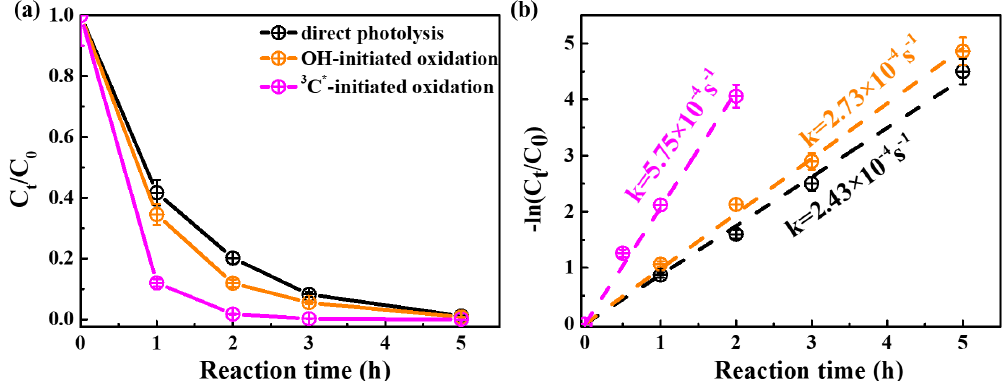
Figure 1. Aqueous-phase eugenol decay kinetic curves (a) and first-order rate constants (b) obtained, based on Eq. (1), under direct photol- ysis, OH-initiated oxidation, and 3 C ∗ -initiated oxidation. The error bar represents 1 standard deviation from the measurements in